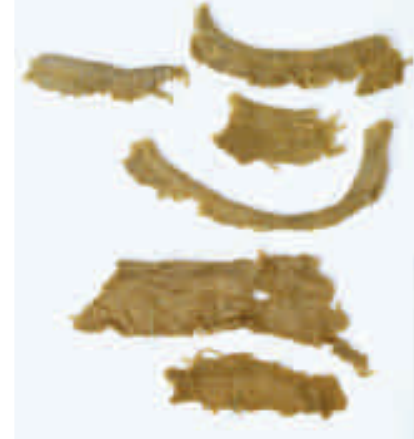
Figure 9 Textile remains interpreted as hauling sacks Figure 11 University of Botswana students during test excavation at KWH1 in 2008